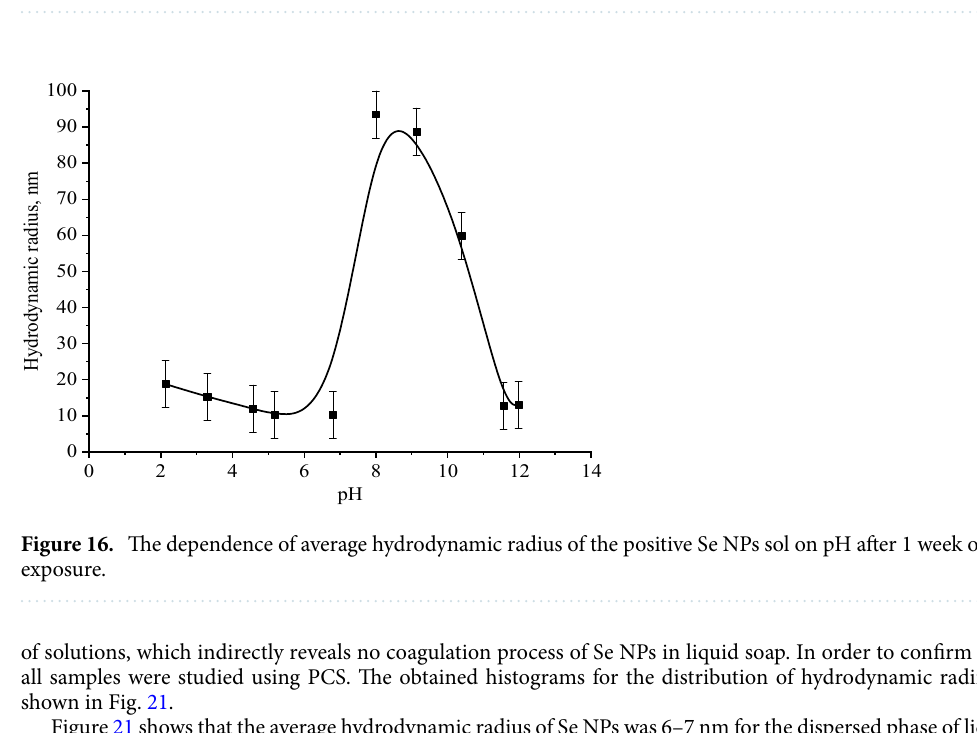
Figure 15. The positive ( a ) and negative ( b ) Se NPs sol at different pH values.